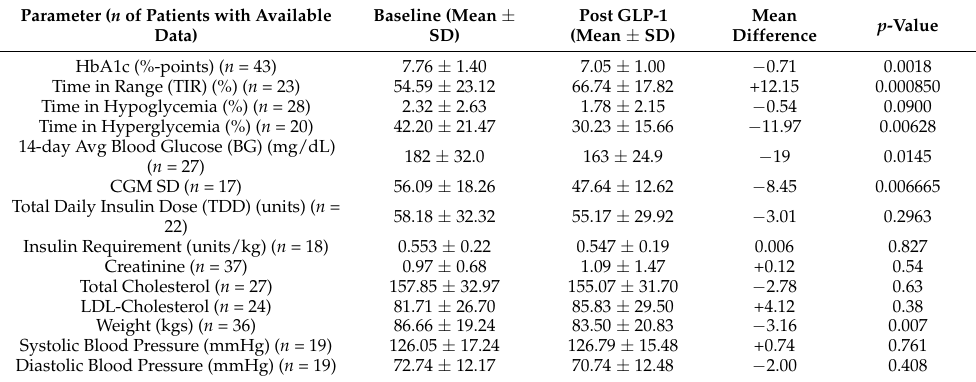
Table 3. Participant HbA1c, glycemic trends, insulin dose, cholesterol and creatinine levels, weight, and blood pressure at baseline and after 6 months of long-acting